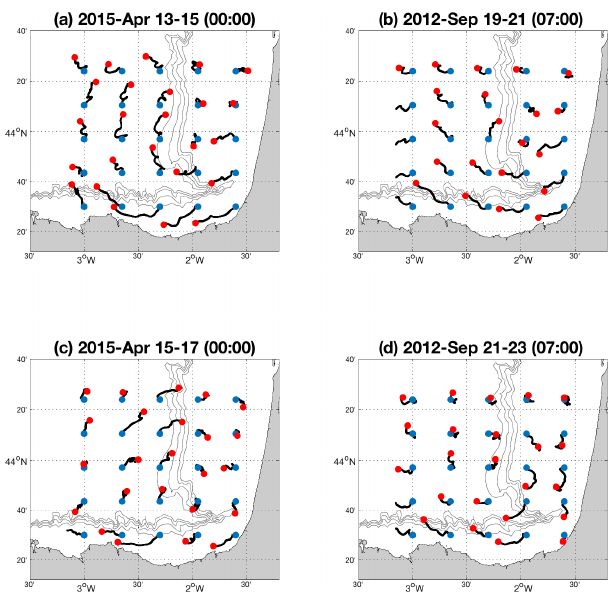
Fig. 4. The time series and spatial distribution of the ε